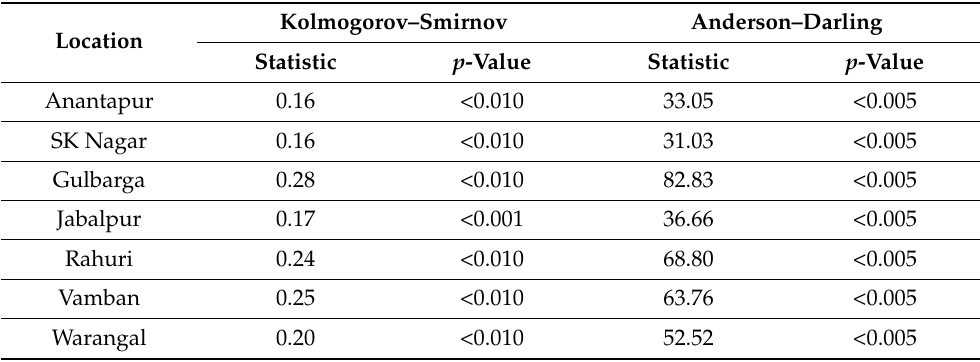
Table 3. Goodness-of-Fit Tests for Normal